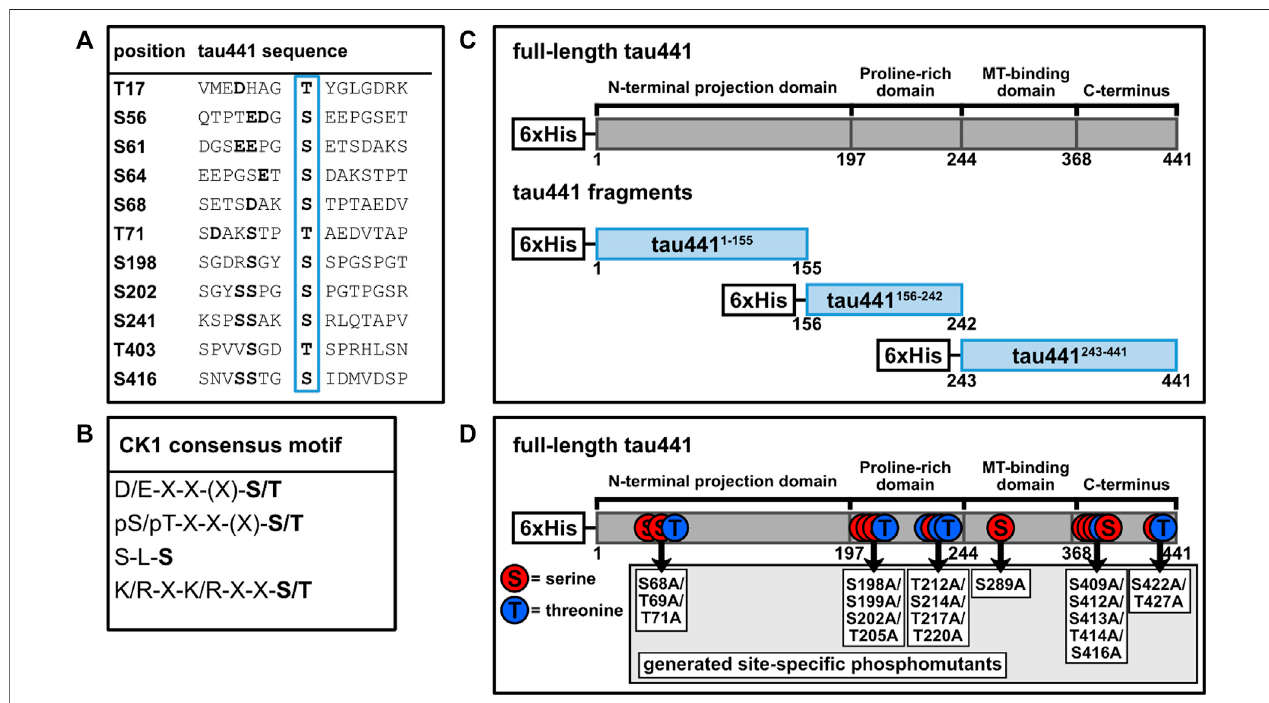
FIGURE 1 | Tau441 contains several potential target sites for CK1. (A) Adjacent amino acid sequences of potential phosphorylation sites for CK1 on tau441 predicted by ScanSite 4.0 at low stringency according to Krismer et al. (2021). (B) Consensus motifs for CK1. (C) Tau441 fragments were generated according to different tau domains. (D) Tau441 phosphomutants were generated according to the positions of the predicted CK1 phosphorylation sites or the detection via MS analysis. MT: microtubule, pS/pT: pre-phosphorylated serine or threonine, S: serine, T: threonine, X: no amino acid